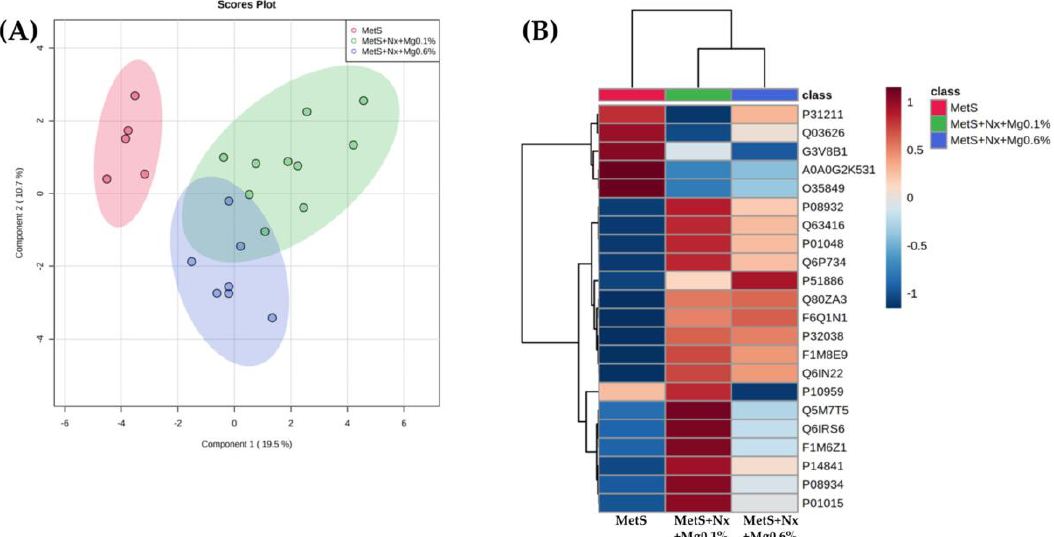
Figure 5. Dietary Mg supplementation modified the expression of 22 proteins related to inflammation, oxidative stress and atherosclerosis in rats with metabolic syndrome and 5/6 nephrectomy. A Plasma proteomic study was performed by DIA/SWATH. ( A ) Principal component analysis (PCA) score plot from fold-change values of the different experimental groups. ( B ) Heat map analysis of the 22 proteins with significantly altered expression levels. All the significantly altered proteins were grouped into 3 clusters (Red = MetS; Green = Mets+Nx+Mg0.1% and Blue = Mets+Nx+Mg0.6%).